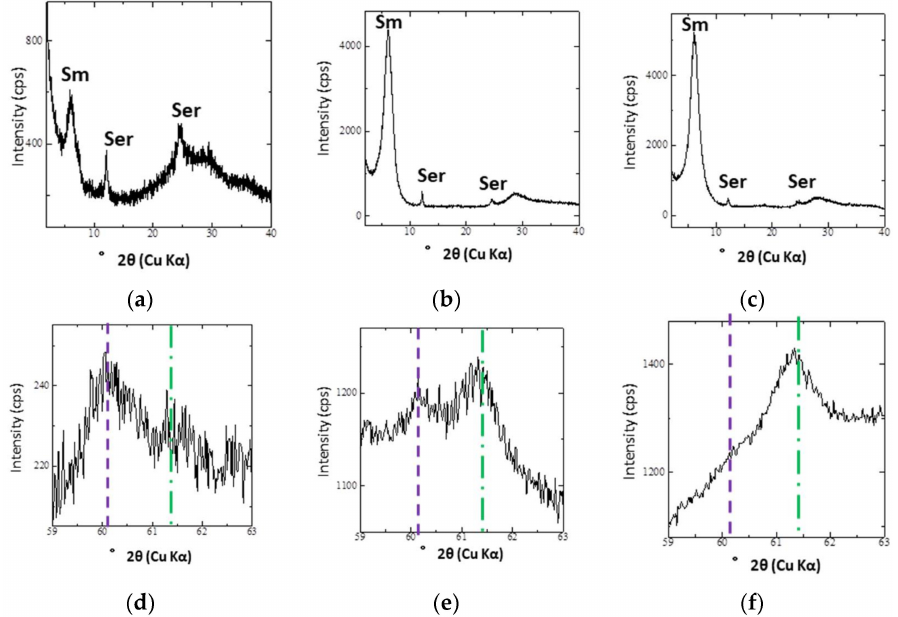
Figure 5. XRD traces of the <2 µ m fraction of DH4 at different depths: ( a ) Oriented XRD traces at 3 m; ( b ) Oriented XRD traces at 6 m; ( c ) Oriented XRD traces at 10 m; ( d ) XRD traces of the 060 reflection at 3 m; ( e ) XRD traces of the 060 reflection at 6 m; ( f ) XRD traces of the 060 reflection at 10 m. Sm: smectite; Ser: